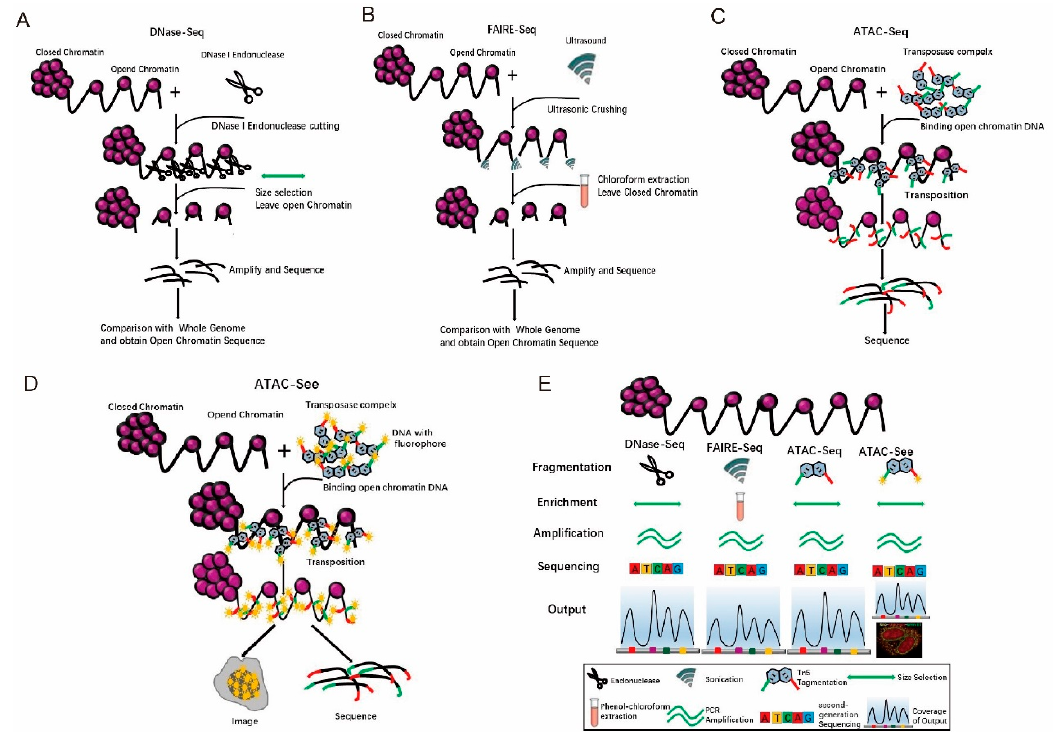
Figure 4. Tn5 is used to study open chromatin. ( A ). The principles and processes of DNase-seq. ( B ). The principles and processes of FAIRE-seq. ( C ). The principles and processes of ATAC-seq. ( D ). The principles and processes of ATAC-Seq. ( E ). Comparison of multiple methods for studying open chromatin.